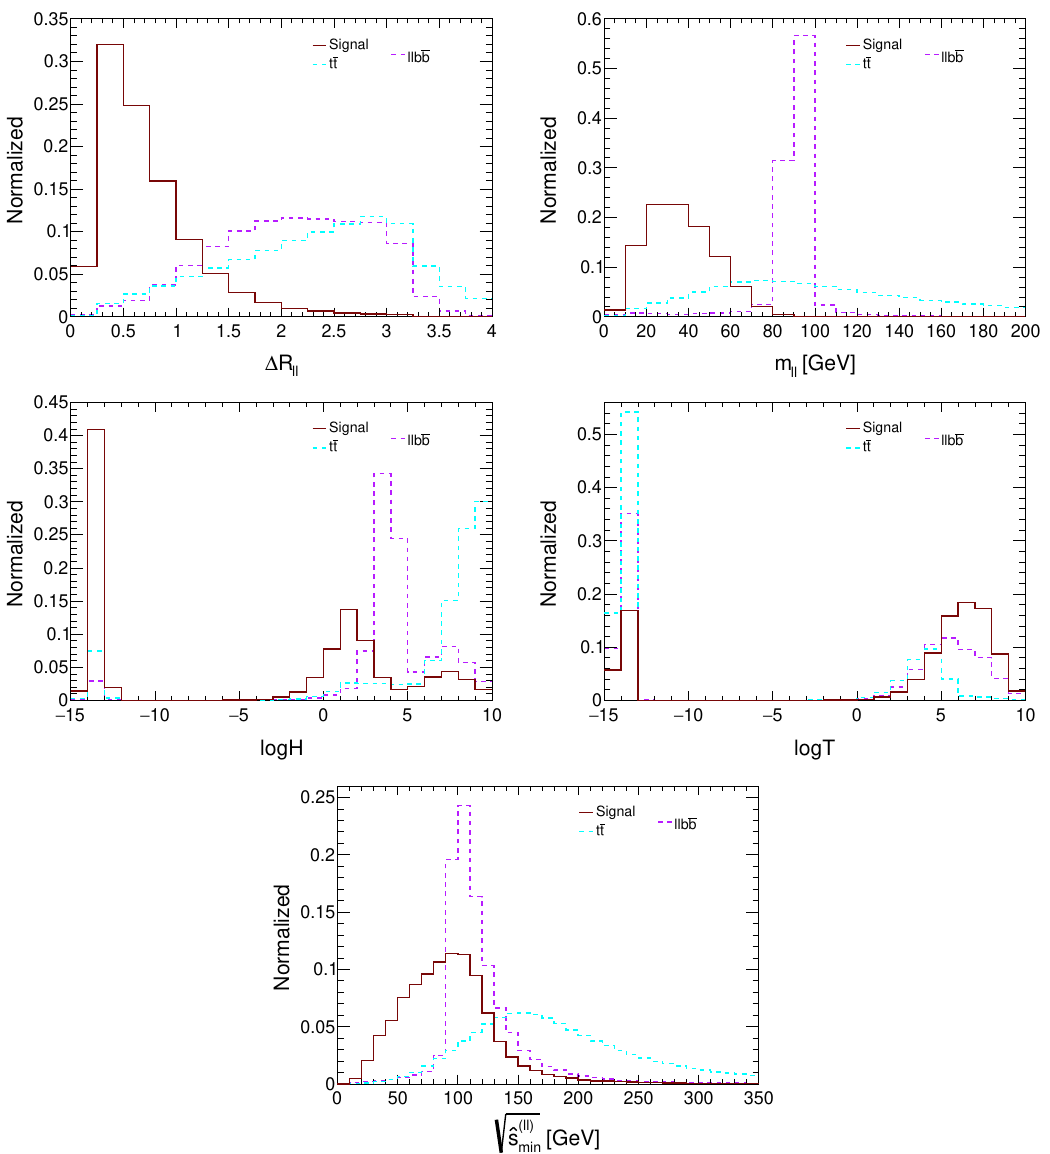
q ˆ s ( ‘‘ ) for the b ¯ bWW ∗ → min